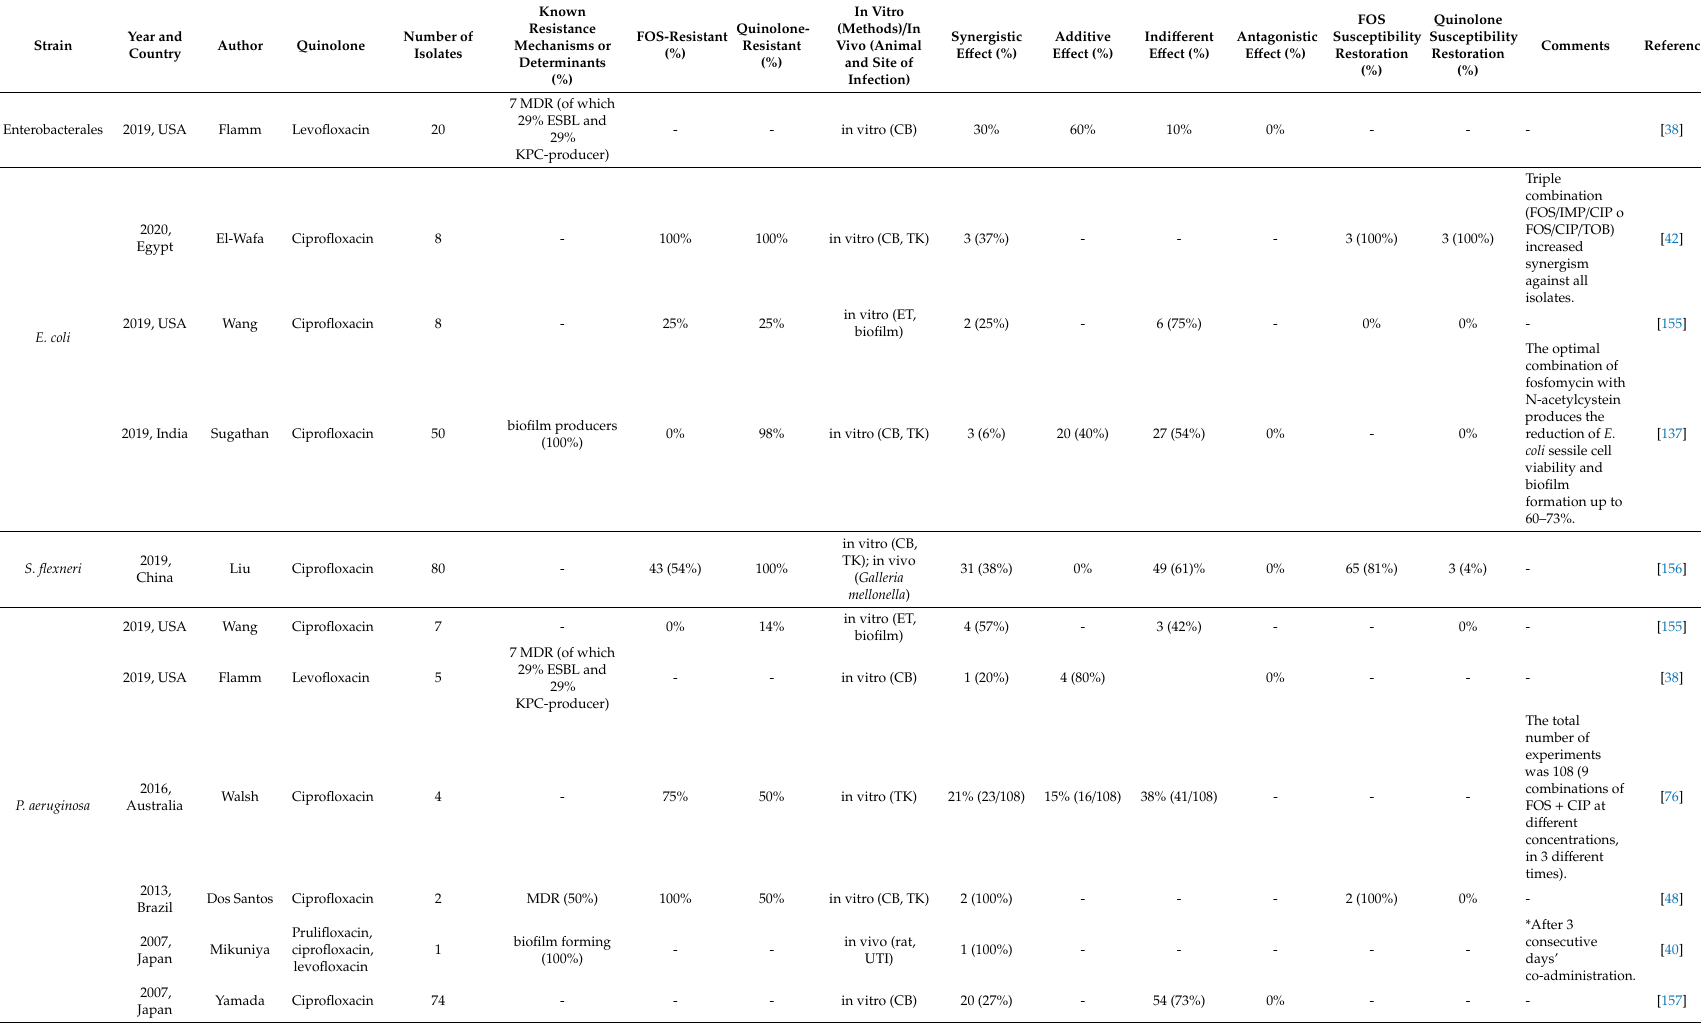
Table 5. Studies on combination between fosfomycin and quinolones. CB: checkerboard assay; TK: time–kill assay; ET: